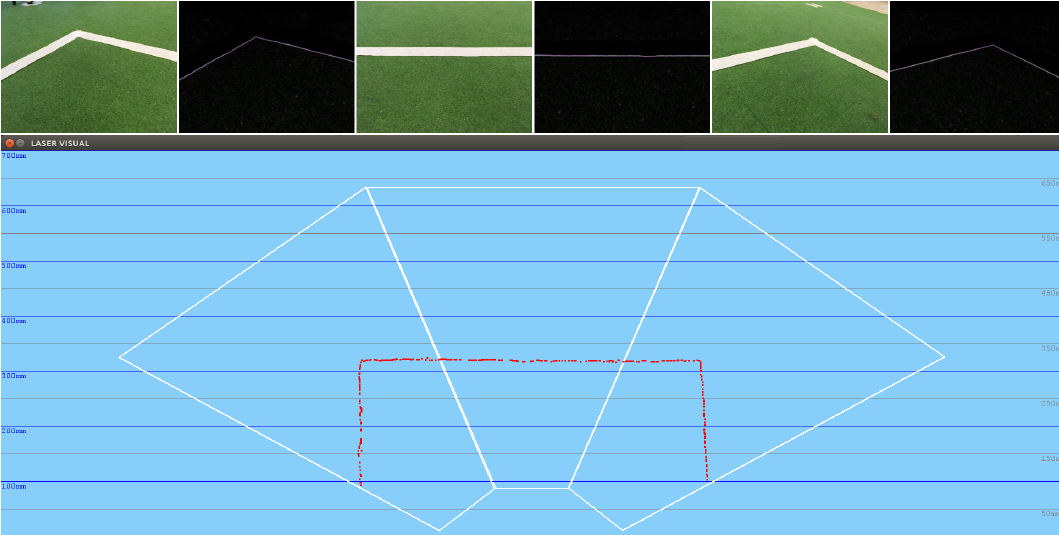
Figure 16. Intelligent navigation thanks to the three-phase visual